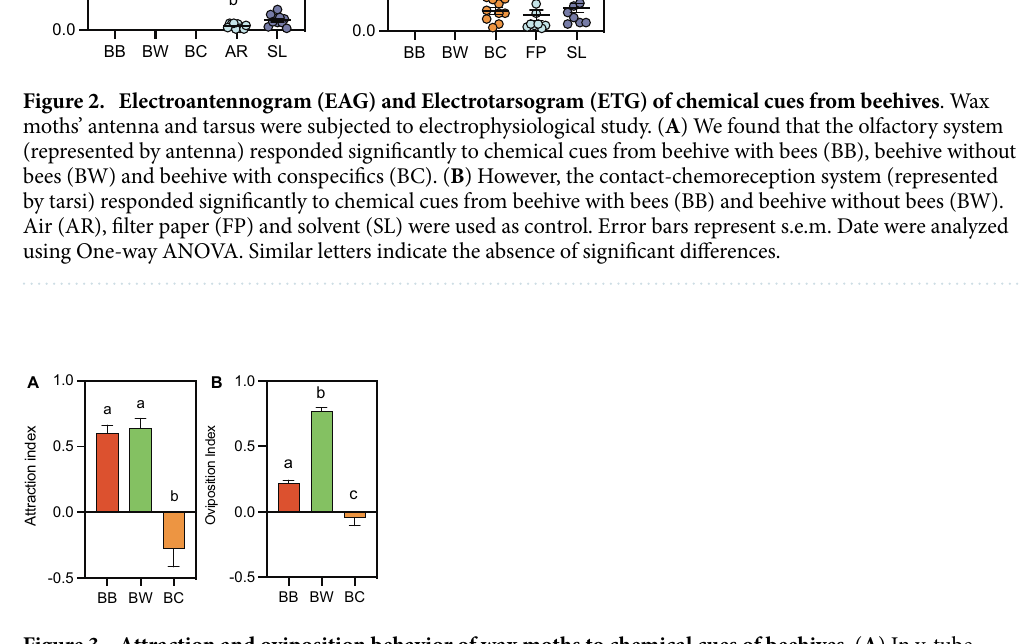
Figure 3. Attraction and oviposition behavior of wax moths to chemical cues of beehives . ( A ) In y-tube olfactometer assays, we showed that gravid female wax moths were significantly attracted to chemical cues of beehive with bees (BB) and beehive without bees (BW). However, the chemical cues of beehive with conspecifics (BC) were less attractive to moths. ( B ) Similarly, in oviposition assays, gravid moths preferred to lay significantly more eggs on filter paper with chemical cues of beehive without bees (BW) than on filter paper with chemical cues of beehive with bees (BB) or beehive with conspecifics (BC). Error bars represent s.e.m. Significant difference was analyzed by One-way ANOVA. Similar letter significs that the means are not significantly